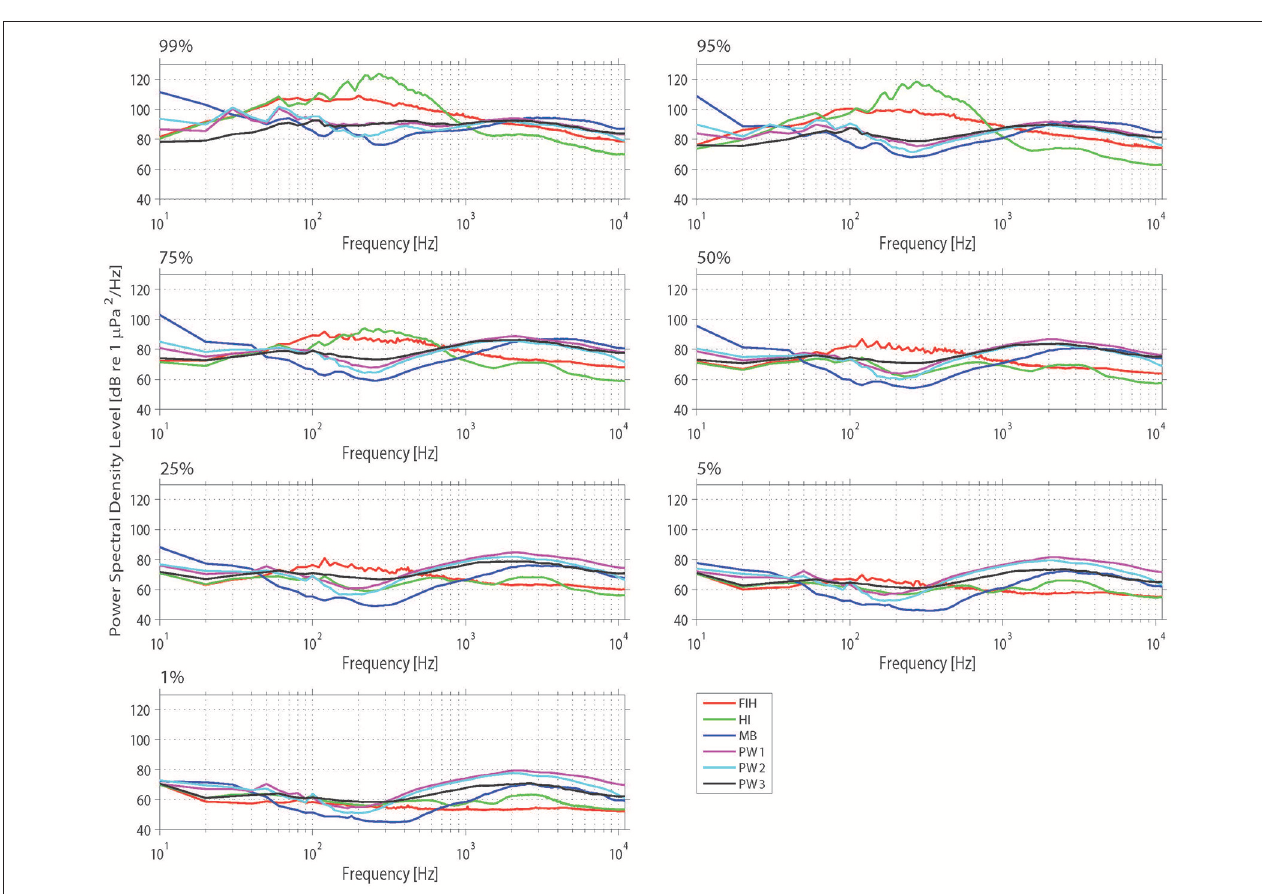
FIGURE 6 | Power spectrum density (PSD) percentiles (averaged into 10 Hz bands) from the four sites considered in the spatial analysis. The n th percentile gives the level that was exceeded n% of the time.